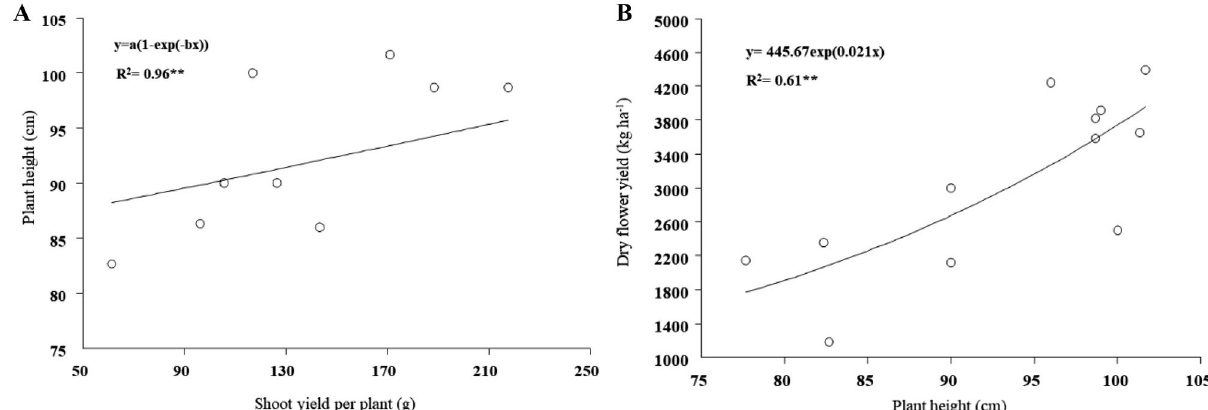
Figure 4. Indirect effect of shoot weight per plant on the dry flower yield of Echium amoenum mediated by plant height: ( A ) exponential relation between plant height and shoot yield, ( B ) exponential relation between plant height and dry flower